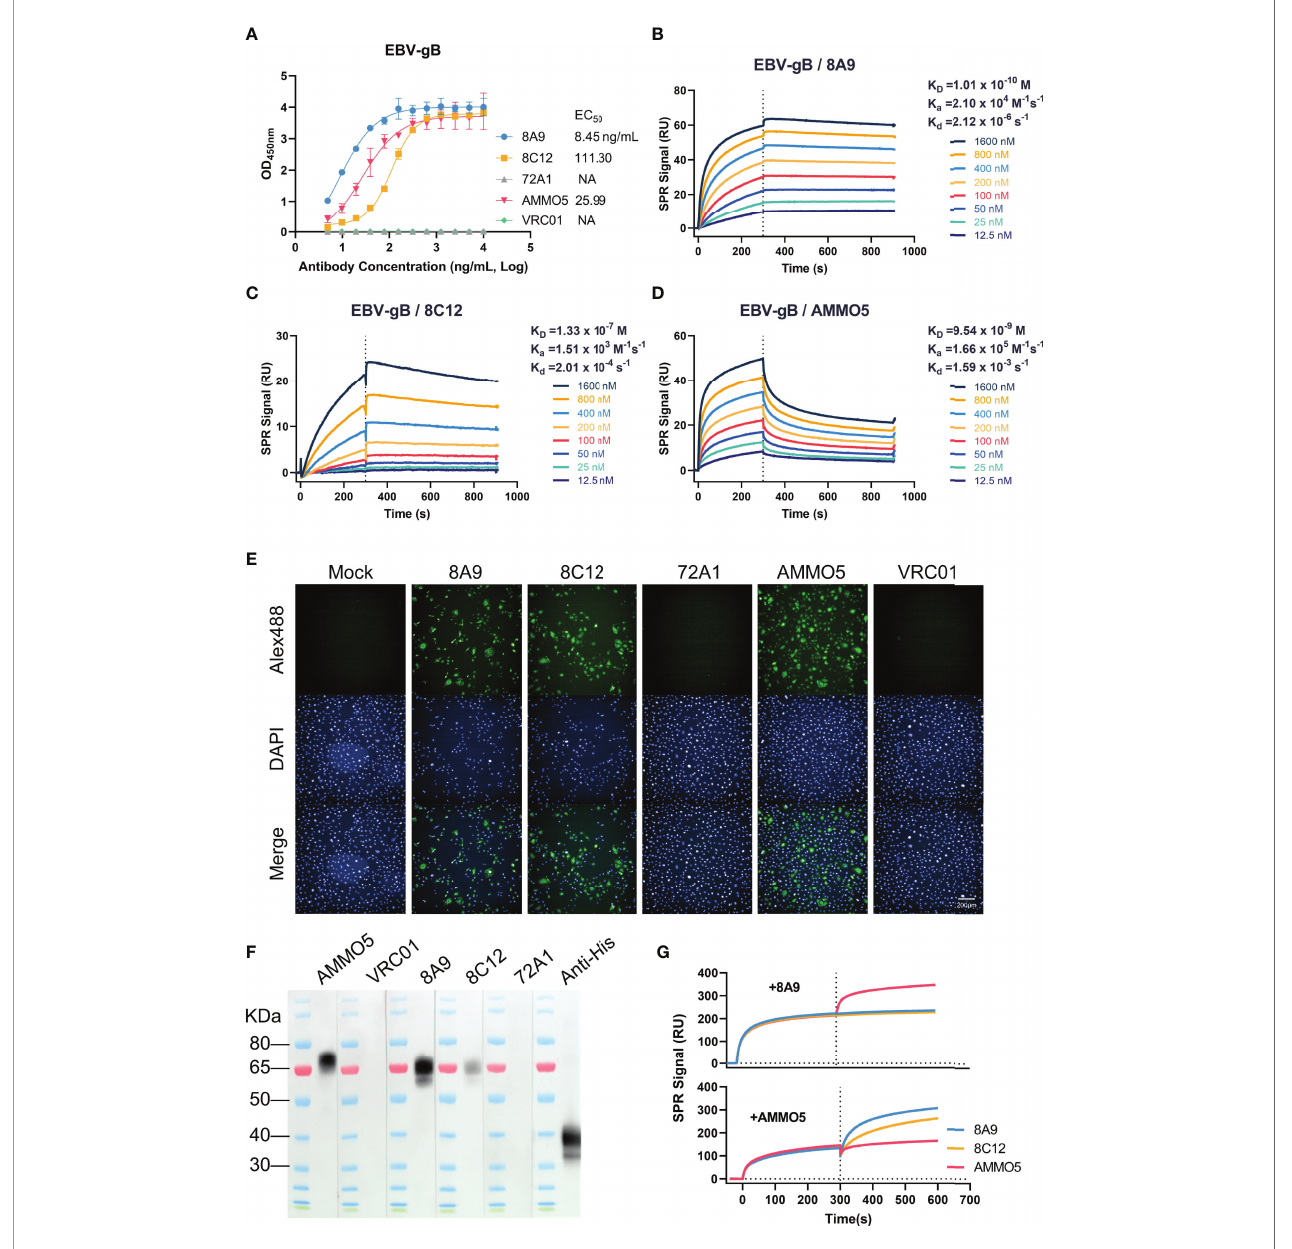
FIGURE 1 | Evaluation of the binding abilities of 8A9, 8C12, and AMMO5. (A) The binding abilities of 8A9, 8C12, and AMMO5 against the recombinant gB ectodomain were detected using ELISA. (B – D) The binding af fi nities of gB NAbs against immobilized gB were measured using the SPR assay. (E) The reactivities of MAbs with native full-length gB expressed in MDCK cells were measured by the immuno fl uorescence (IF) assay. (F) Detection of reactivities against denatured gB using the Western blot assay. The gp350 antibody 72A1 was used as a negative control for murine antibodies. The HIV-ENV antibody VRC01 was used as the negative control for the human antibody. (G) Epitope competition was detected using SPR by preincubating with 8A9 or